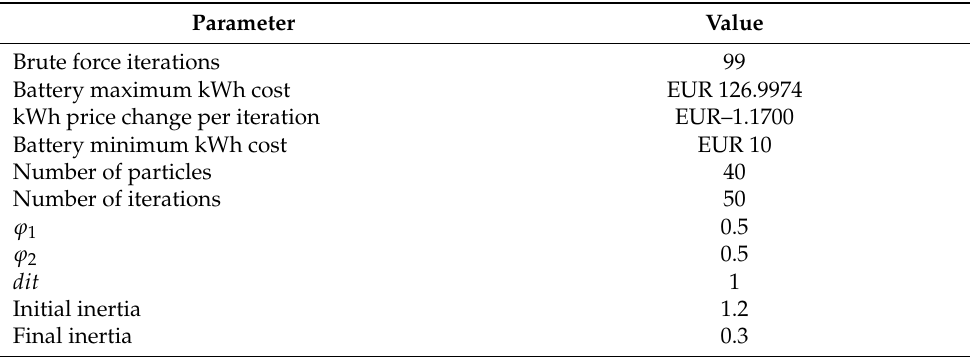
Table 5. Sensitivity algorithm